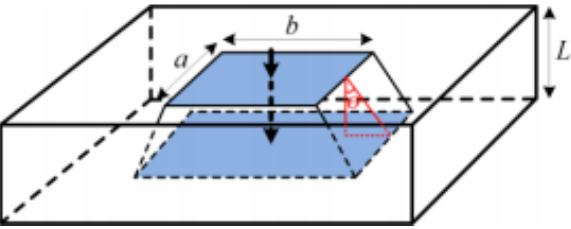
Figure 3. Heat dissipation area on single layer dielectric of IGBT modules.